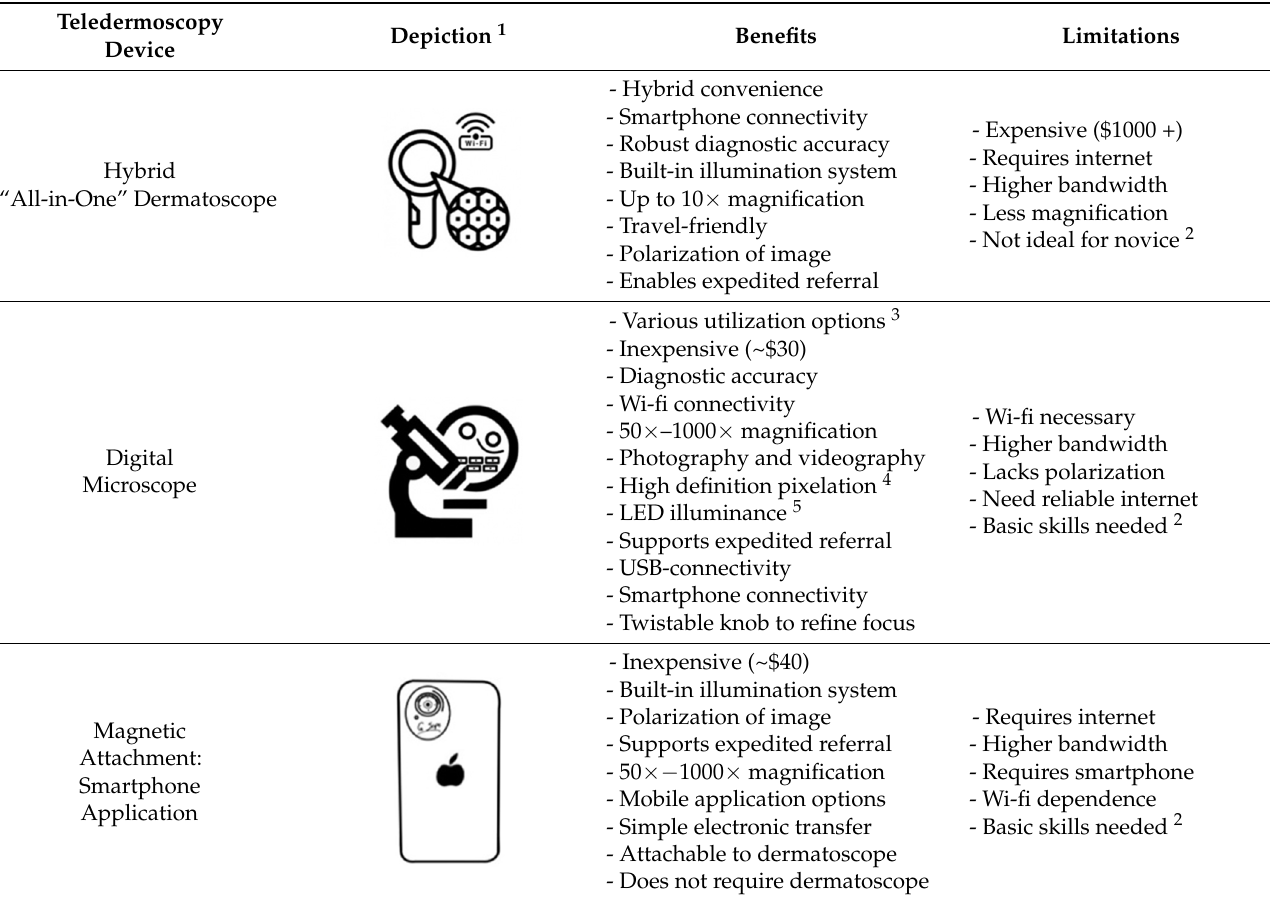
Table 2. Teledermoscopy technologies. Summary of distinct benefits and limitations.